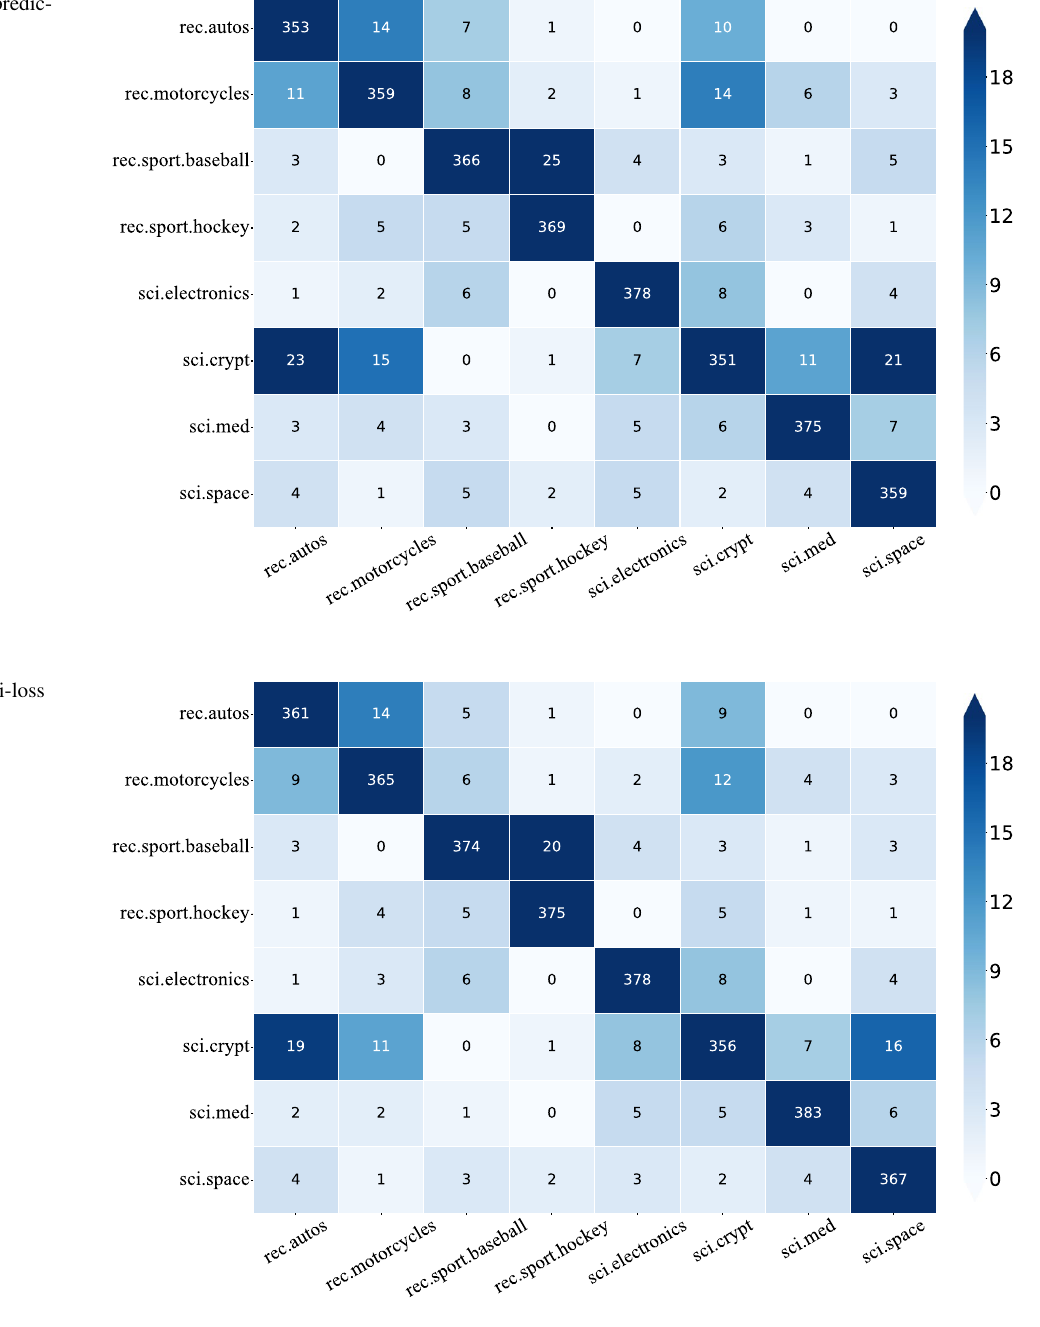
Fig. 14 Testing on basic predic- tor